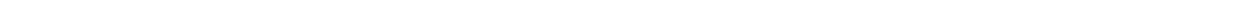
Fig. 2 Using spiking neural networks to mimic dynamics with FORCE training. a The voltage trace for 5 randomly selected neurons in networks of 2000 integrate-and- fi re spiking neurons. The models under consideration are the theta neuron (left), the leaky integrate-and- fi re neuron (middle), and the Izhikevich model with spike frequency adaptation (right). For all networks under consideration, a spike was deleted (black arrow) from one of the neurons. This caused the spike train to diverge post-deletion, a clear indication of chaotic behavior. b A network of 2000 theta neurons (blue) was initialized in the chaotic regime and trained to mimic different oscillators (black) with FORCE training. The oscillators included the sinusoid, Van der Pol in harmonic and relaxation regimes, a non-smooth sawtooth oscillator, the oscillator formed from taking the product of a pair of sinusoids with 4 Hz and 6 Hz frequencies, and the same product of sinusoids with a Gaussian additive white noise distortion with a standard deviation of 0.05. c Three networks of different integrate-and- fi re neurons were initialized in the chaotic regime (left), and trained using the FORCE method (center) to mimic a 5 Hz sinusoidal oscillator (right). d A network of 5000 theta neurons was trained with the FORCE method to mimic the Lorenz system. RLS was used to learn the decoders using a 45 s long trajectory of the Lorenz system as a supervisor. RLS was turned off after 50 s with the resulting trajectory and chaotic attractor bearing a strong resemblance to the Lorenz system. The network attractor is shown in three different viewing planes for 50 s post